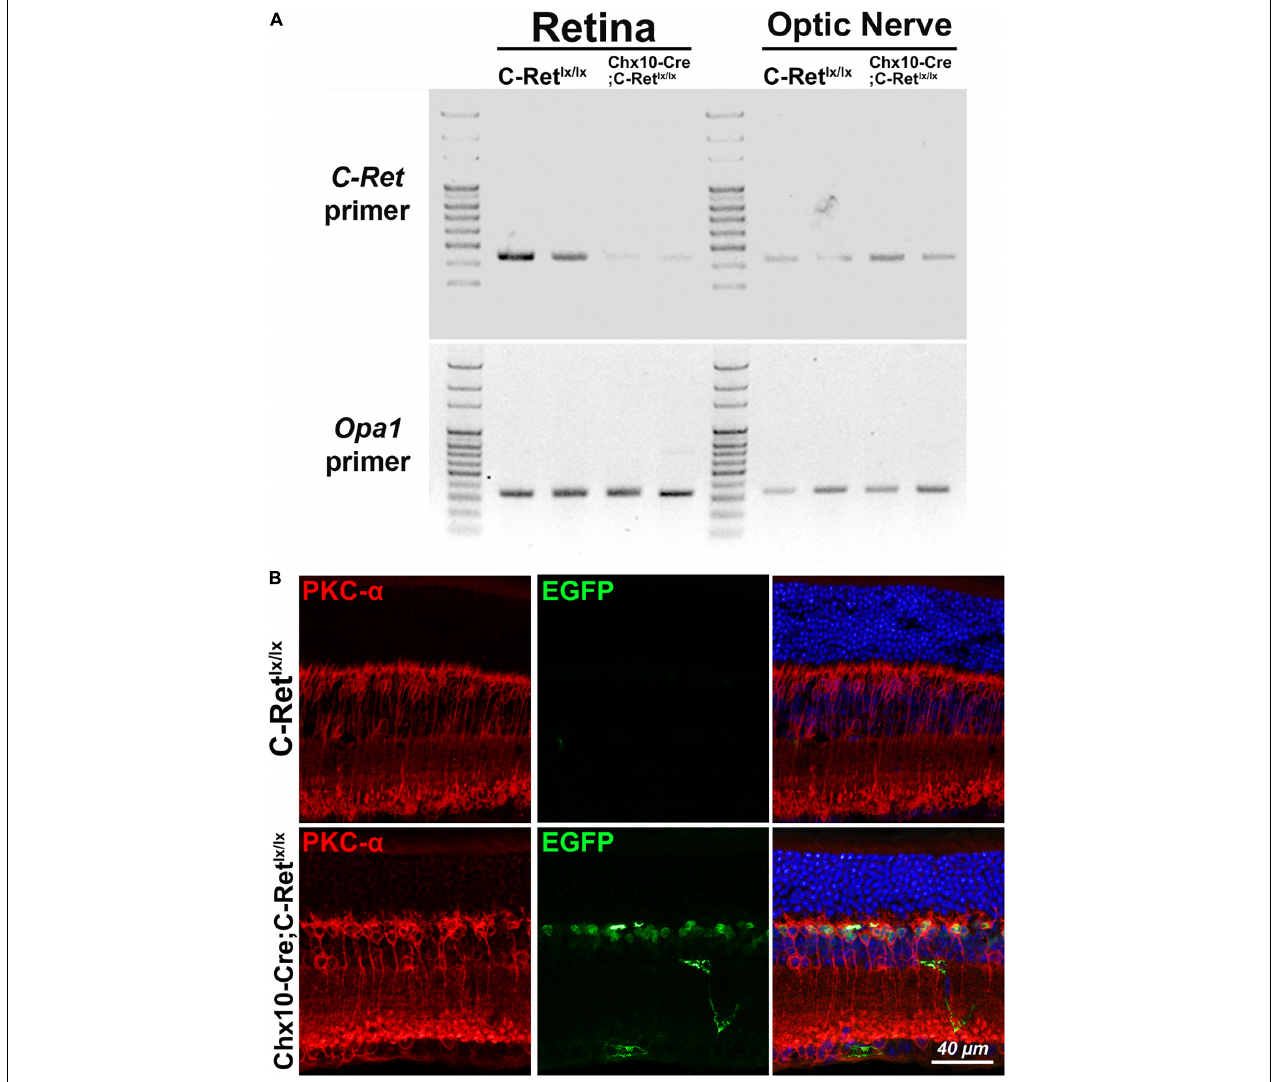
FIGURE 2 | Amplification of C-Ret gene and immunohistochemistry of GFP in C-Ret lx / lx and Chx10-Cre;C-Ret lx / lx mice. ( A , top) Polymerase chain reaction (PCR) was performed using C-Ret primers to screen the presence of exon 12 within the C-Ret gene. The results showed that barely any amplification occurred in the retinae of Chx10-Cre;C-Ret lx / lx mice compared to that in the retinae of C-Ret lx / lx mice. PCR was able to amplify C-Ret gene from optic nerve in both C-Ret lx / lx and Chx10-Cre;C-Ret lx / lx mice. ( A , bottom) PCR analysis using Opa1 primers showed equally amplification between C-Ret lx / lx and Chx10-Cre;C-Ret lx / lx mice in retinae and optic nerve tissue. (B) Retinal sections of animals aged 12 months were immunostained with anti-PKC- α (red) and anti-EGFP (green) antibodies to label rod bipolar and GFP expressing cells, respectively, followed by counterstaining with Hoechst dye, to indicate cell nuclei (blue). PKC- α (red) was expressed in cytoplasm of bipolar cells in C-Ret lx / lx and Chx10-Cre;C-Ret lx / lx mice; however, the GFP was only expressed in the nucleus of bipolar cells of Chx10-Cre;C-Ret lx / lx mice due